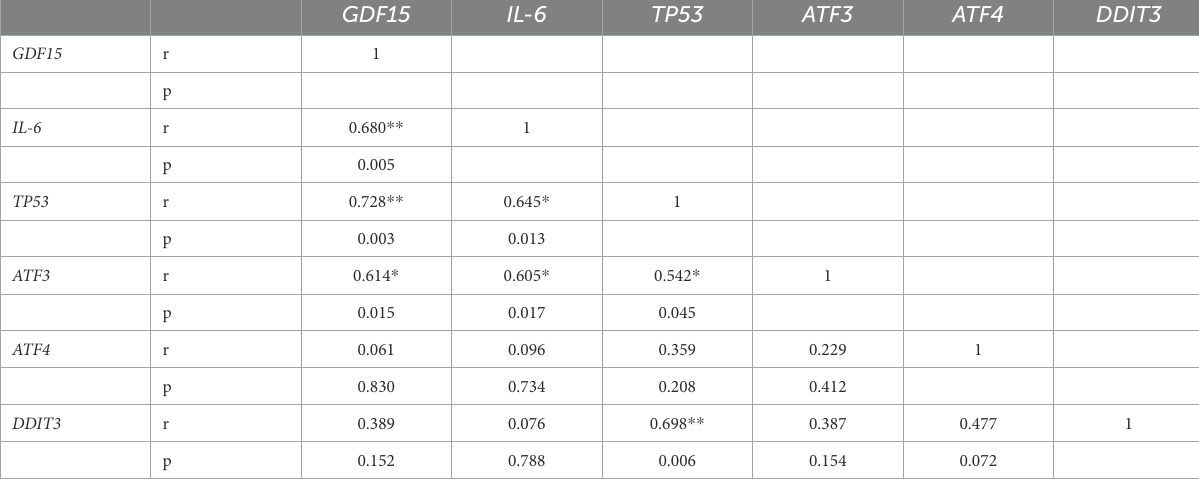
TABLE 3 Pearson correlation analysis among mRNA levels of tested genes in frontal cortex from 10 Alzheimer’s disease (AD) and 5 non-demented old subjects